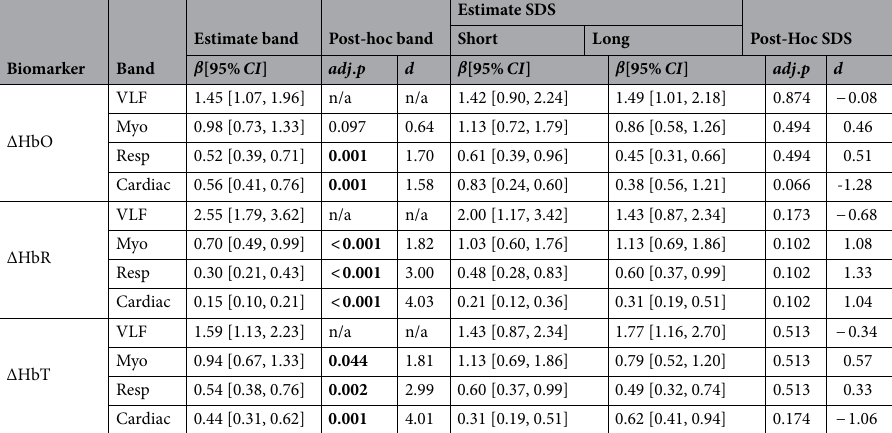
Table 2. Differences in relative energy density ( rel ε ) values between bands and between SDS measurements for each band per biomarker of hypercapnic stimulus. β Estimate, CI confidence interval, adj . p FDR adjusted p values with bolded values representing significance at α < 0.05; d Cohen’s d. In post-hoc band column, the metrics represent differences between very low frequency (VLF) and other bands (e.g., Myogenic – VLF), where positive d means that the effect was more pronounced in VLF band. Alternatively, in post-hoc SDS column the metrics represent differences between short- and long-SDS measurements, where negative d values mean the effect was more pronounced in long-SDS